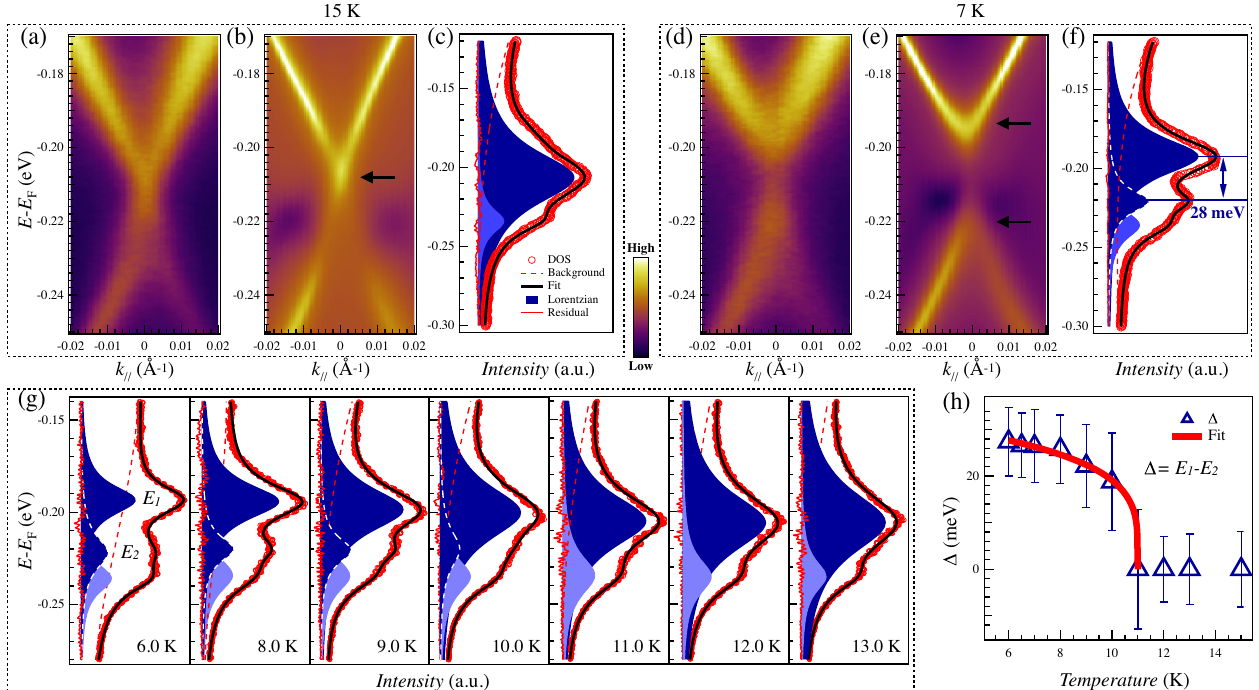
FIG. 3. Temperature dependence of the TSS gap in the S termination of MnBi 8 Te 13 . (a) Enlarged ARPES spectrum of the S termination measured at 15 K (PM phase). (b) Two-dimensional curvature plot for the spectrum in panel (a). (c) Energy distribution ¯ Γ curve (EDC) at (integrated over a (cid:3) 0 . 001 Å − 1 momentum window) and its fitting with multiple Lorentzian peaks. (d) – (f) Same plots as those in panels (a) – (c) but for data measured at 7 K (FM phase). (g) EDC fitting analysis at various temperatures, showing a clear gap opening for T ≤ 10 . 0 K. The EDCs for each temperature are extracted from the corresponding spectra shown in Fig. S6 integrated over a (cid:3) 0 . 001 Å − 1 momentum k k window. Furthermore, the spectra for each temperature are extracted from the corresponding map shown in Fig. S5 integrated over a (cid:3) 0 . 002 Å − 1 momentum ( k y ) window. (h) TSS Dirac cone gap size (blue triangles) evolution with temperature and its fitting (red solid line) using a power-law curve. The error bar of the gap size is defined as e ¼ represent the half width at half maximum for peaks E 1 and E 2 , respectively. We note that the EDC fitting in panel (g) yields the standard deviation of the peak positions much smaller (less than 1 meV) than the error bars shown in panel